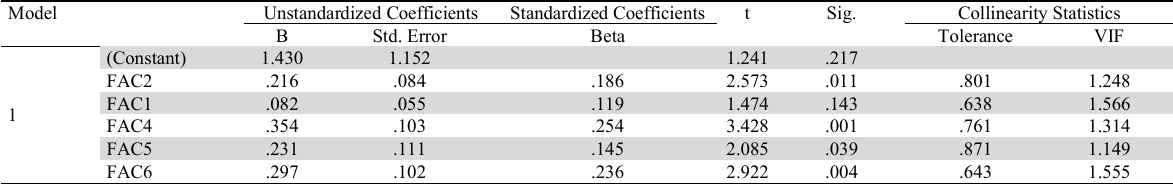
The results of regression estimate Model Unstandardized